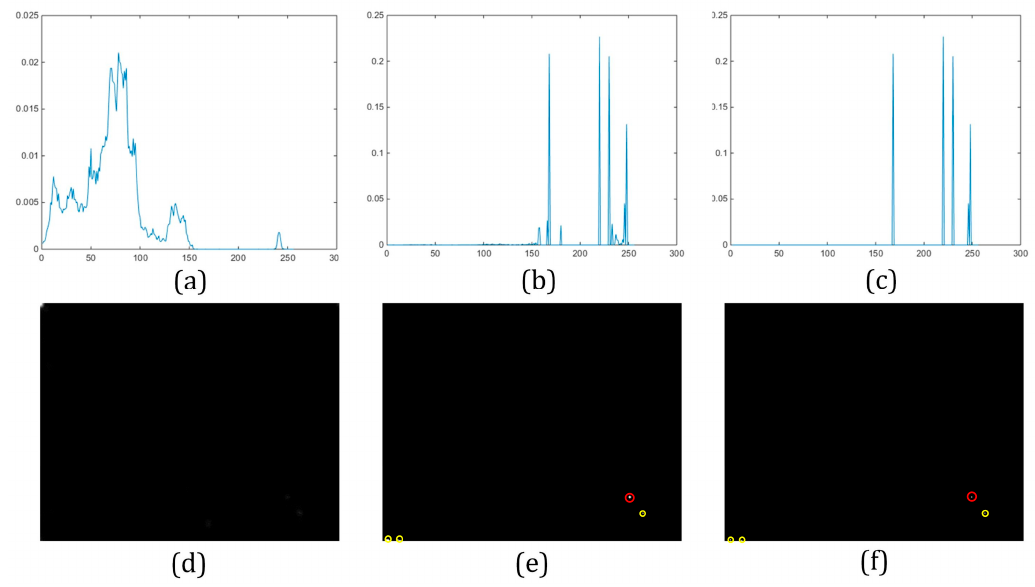
Figure 8. In-frame detection results of Seq.4 generated by our method: ( a ) intensity histogram; ( b ) original saliency histogram; ( c ) modified saliency histogram; ( d ) saliency map; ( e ) binarized image; ( f ) in-frame detection result.